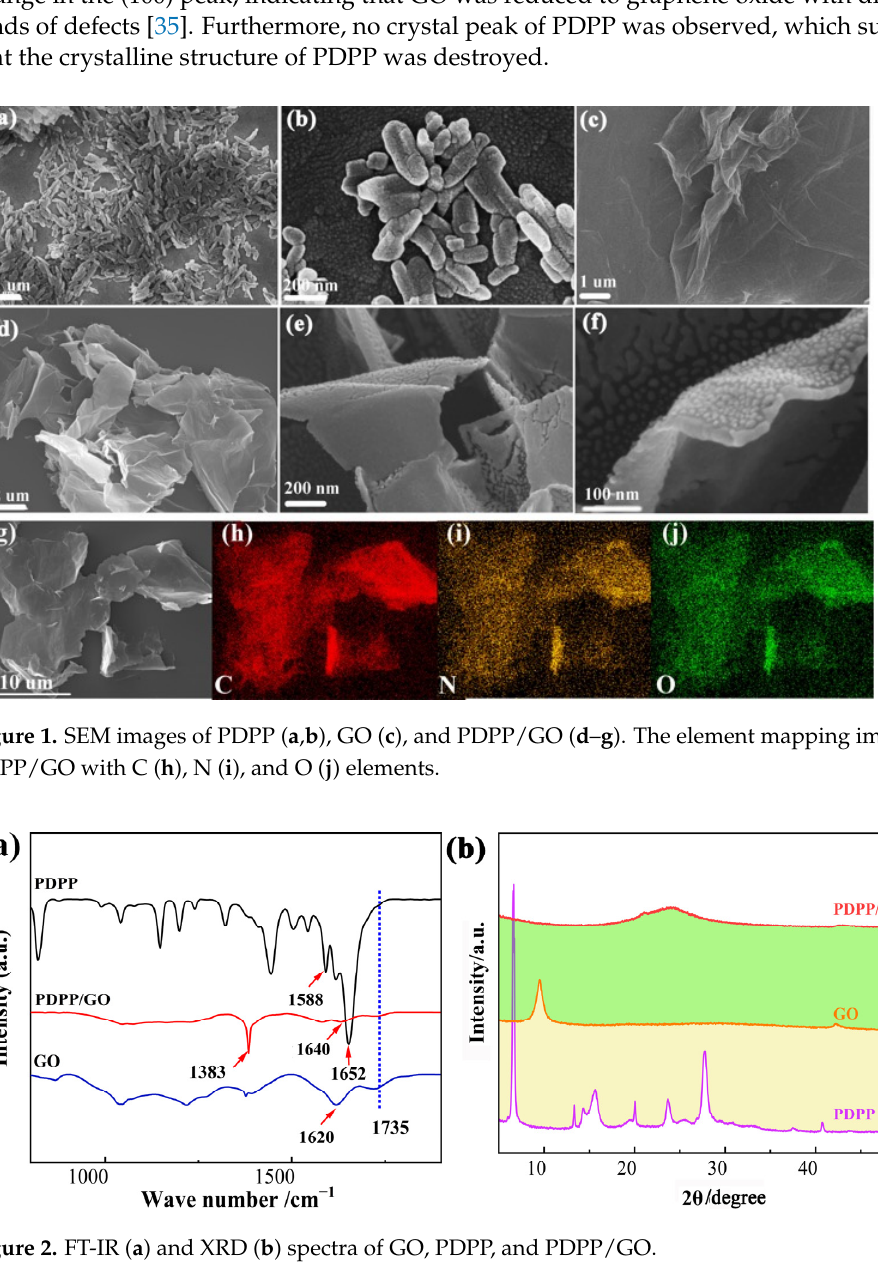
Figure 2. FT-IR ( a ) and XRD ( b ) spectra of GO, PDPP, and PDPP/GO.